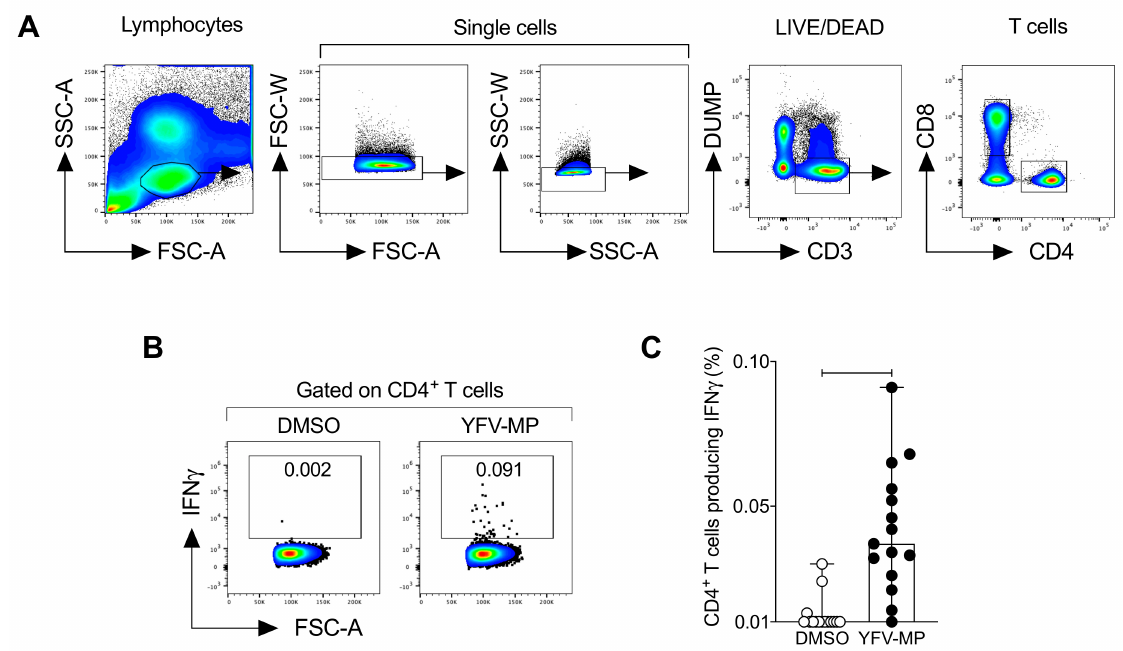
Figure 2. Validation of YVF-MP in vaccine individuals. ( A ) Representative dot plot of the gating strategy for CD4 + T cell selection. Lymphocytes were identified in forward scatter (FSC), and side scatter (SSC) plots. The doublets, CD14 + , and CD19 + cells were excluded. Next, gated on CD3 + cells, the CD4 + and CD8 + population was selected. ( B ) Representative dot plot of gating strategy for antigen-specific CD4 + T cells producing IFN γ after DMSO or YFV-MP stimulation in the same donor. Fifteen samples from YF-17D vaccinees were used for YFV-MP validation. ( C ) Comparison of percentage of CD4 + T cells producing IFN γ between DMSO and YFV-MP stimulated cells. Data are expressed as the median and the range. Statistical analyses were performed using a two-tailed Wilcoxon test. p =